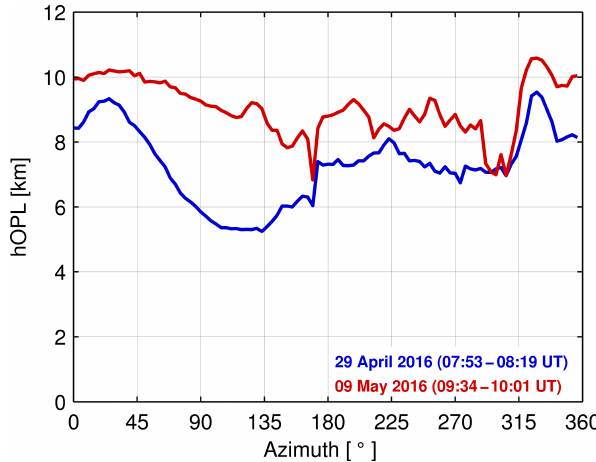
Figure 18. Estimated horizontal optical path length (hOPL) ob- tained from tower DOAS off-axis measurements recorded during two tower platform rotations on 29 April and 9 May 2016.